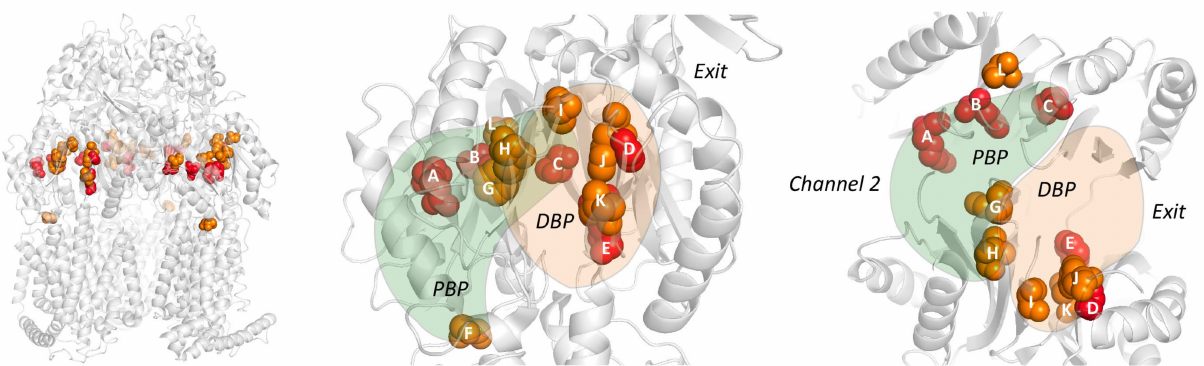
Figure 5. Upcoming gain-of-function mutations in RND-type efflux pumps. Resistant clinically, environmentally and laboratory-evolved strains show an alarming rise in gain-of-function mutations in the binding pockets of homotrimeric RND multidrug efflux pumps. Residues are shown as spheres. From left to right: view of the whole AcrB-Ec trimer, side view and top-down view. Red spheres show the most recurring amino acid substitution (by nonsynonymous mutations in the genes) numbered by letters (A–E), being G228D (AcrB-Sa, “D”), G287A/S (MexY-Pa, “D”), G288C/M/S (AcrB-Ec, “D”), G288S (AdeJ-Ab, “D”), R717Q/L (AcrB-Sa, “A”), R714C/G/H/L (MtrD-Ng, “A”), K823D/E/N (MtrD-Ng, “B”), F136L (AdeJ-Ab, “E”) and K79A/T (MexY-Pa, “C”). Orange shows mutations found in resistant strains (letters F–L), potentially increasing drug resistance; however, the direct effects of the specific mutations have not yet been significantly investigated, or the effect is not clear. These include F178S (“J”), A562V (“F”) and M626V (“H”) (MexB-Pa), S824I (“L”) (LpeB-Lp), V139F (“K”), A279T (“I”) and F617L (“G”) (AcrB-Ec) and S821A (“L”) (MtrD-Ng). The mutations P319L and M78I (AcrB-Sa, Table 9) are not shown, as they are both not present in the binding pockets. Colors: green, proximal binding pocket (PBP); light orange, distal binding pocket (DBP). PDB accession code 3W9H